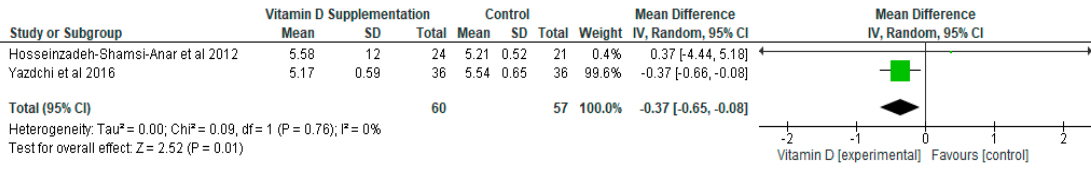
Figure 6. Forest plot of serum insulin concentration µIU/mL. ( a ) Meta-analysis; ( b ) sensitivity analysis. 4. Discussion The results of the systematic review and meta-analysis show that vitamin D supplementation has a significant effect on serum insulin and blood glucose parameters. These results were confirmed by the sensitivity analyses. In particular, there were significant decreases in fasting blood glucose, glycated haemoglobin and serum insulin concentrations in women with GDM compared with the